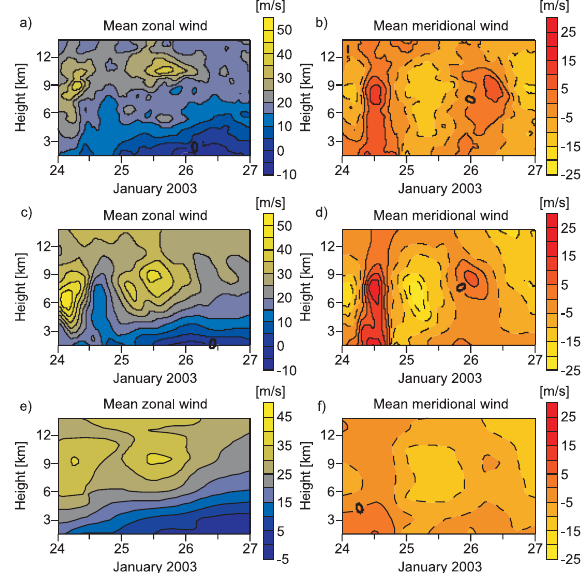
Fig. 2. Mean zonal and meridional winds at Andenes measured by the radar (a, b) , derived from the MM5 model (c, d) and from the ECMWF analysis (e, f) from 24–26 January